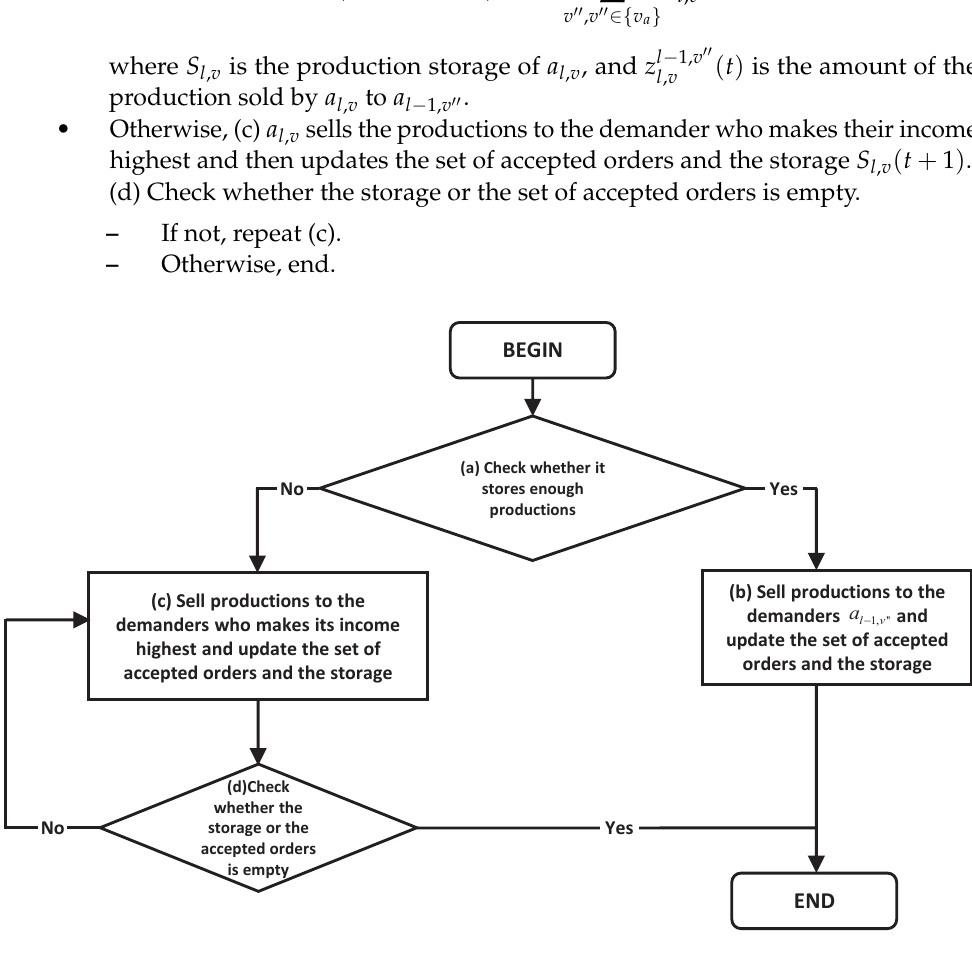
Figure 7. The process of selling